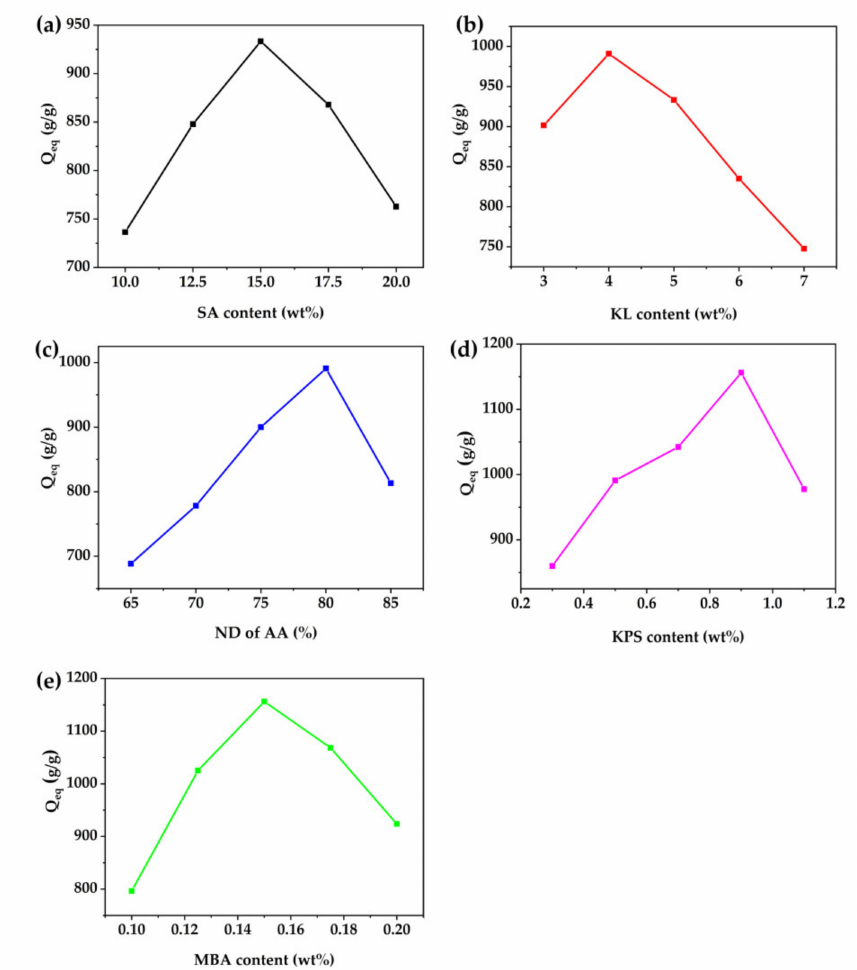
Figure 5. Effects of ( a ) SA content (ST = 15 wt %, KL = 5 wt %, neutralization degree (ND) of acrylic acid (AA) = 80%, potassium persulfate (KPS) = 0.5 wt %, N, N (cid:48)